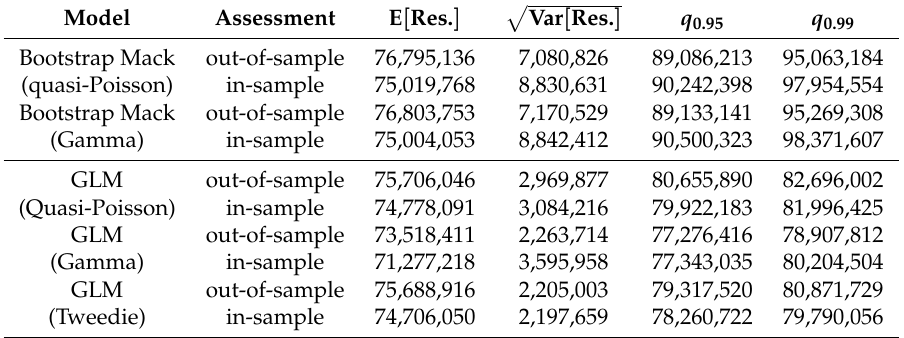
Table 4. Prediction results (incurred but not reported (IBNR) + reported but not settled (RBNS)) for collective approaches.